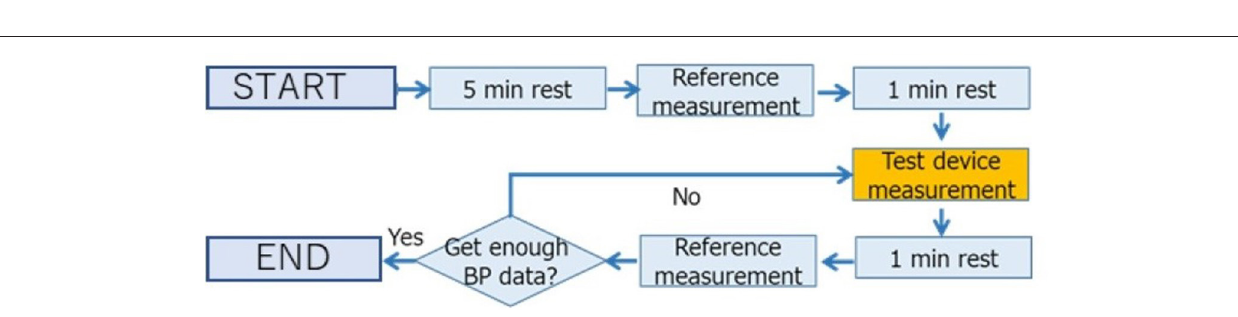
FIGURE 2 | Protocol for collecting data. We took the measurement using the test device in each participant at least three times.